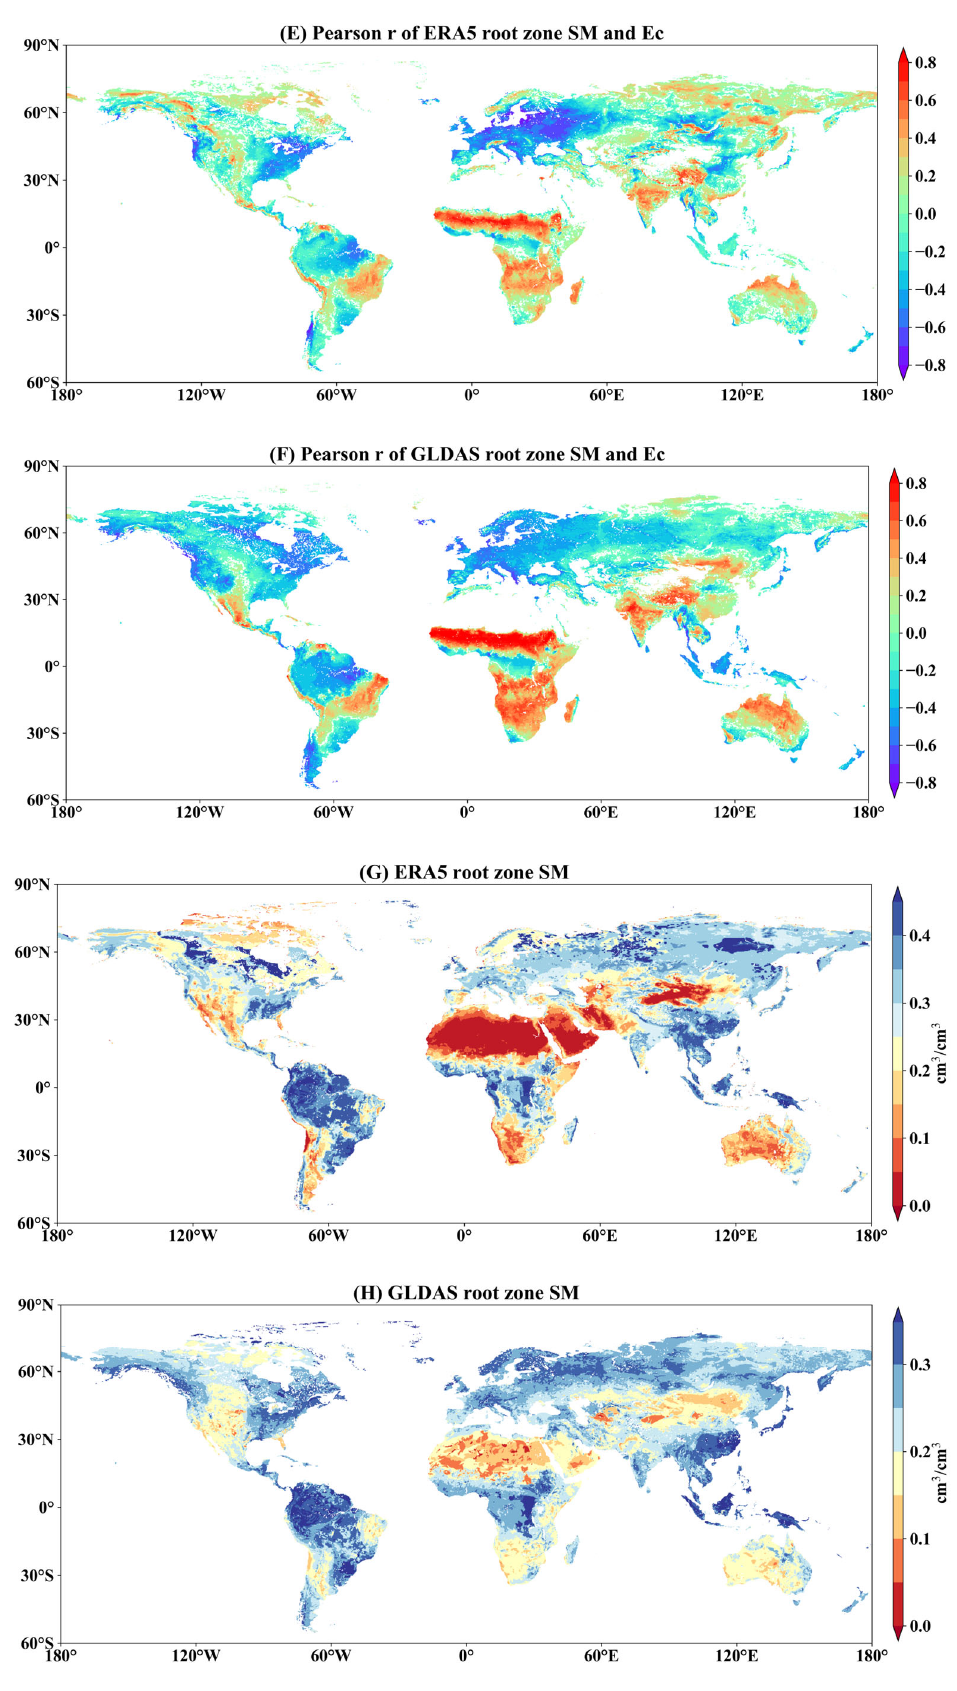
Figure 3. Spatial distribution of Pearson r of SM and ET